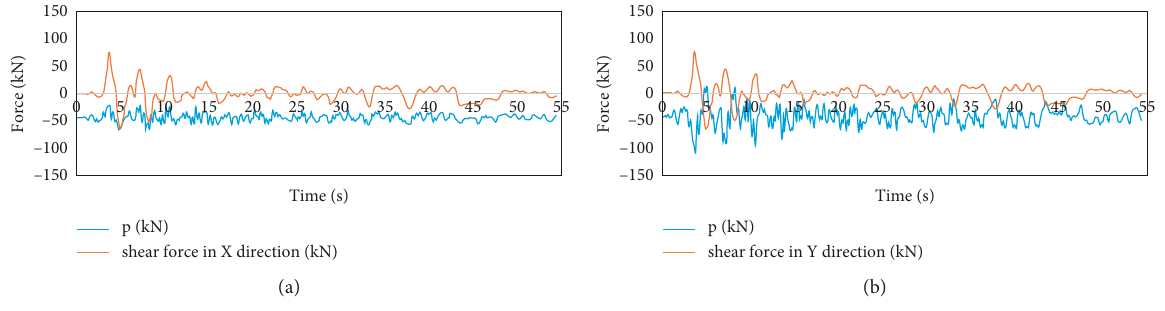
Figure 44: Time course curves of bearing stresses under TAF seismic waves. (a) X-directional input. (b) Y-directional